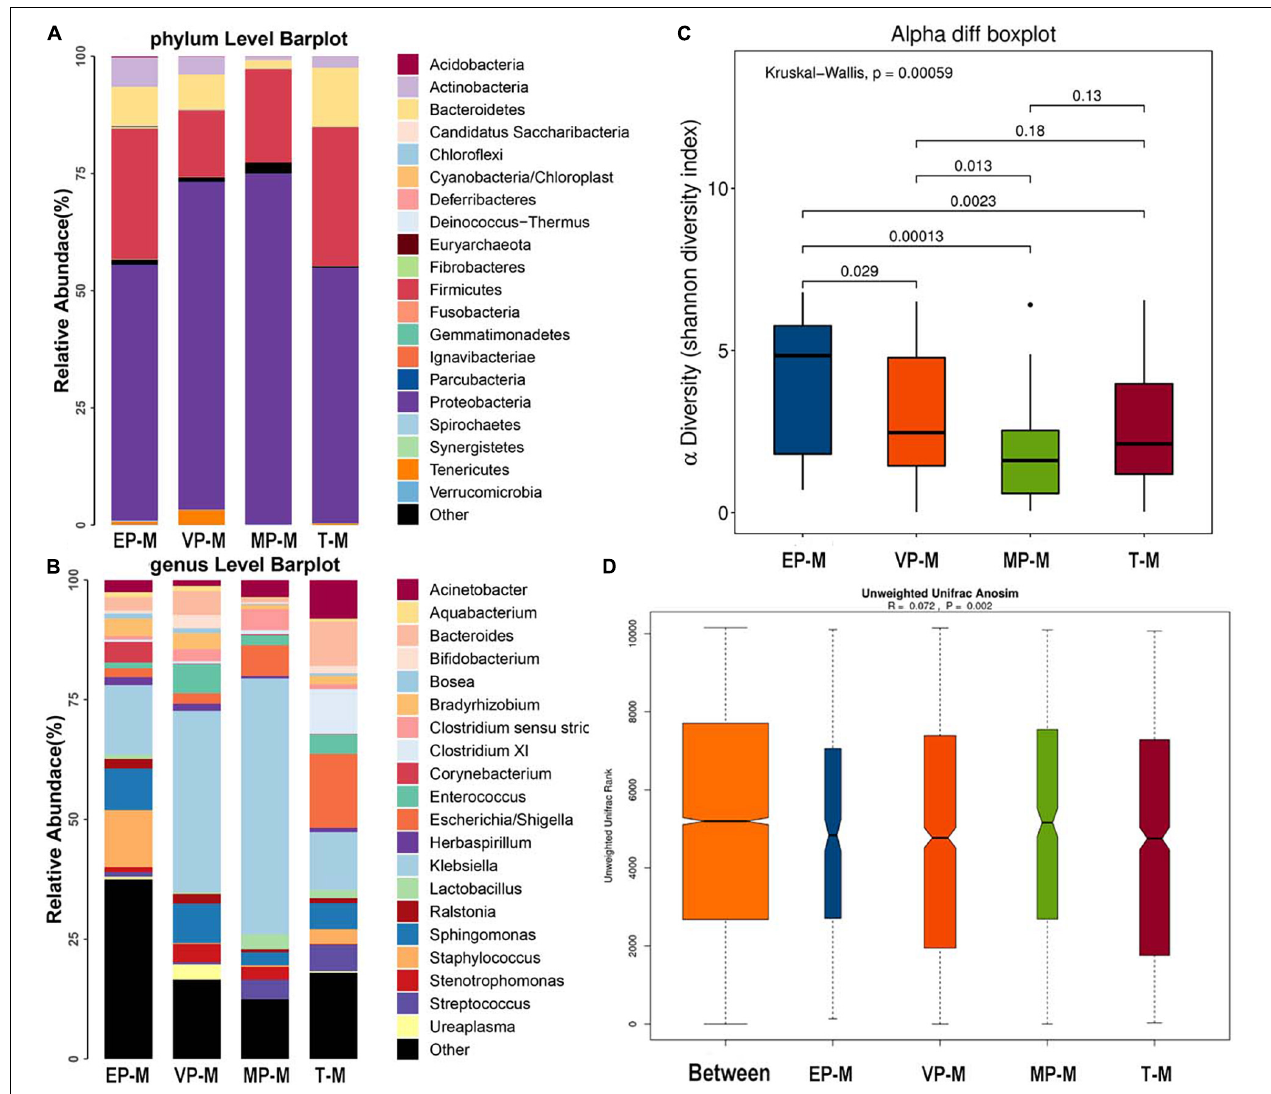
FIGURE 2 | The composition of gut microbiota from neonates with different gestational ages at first day after birth. EP, extremely preterm ( < 28 weeks); VP, very preterm (28–32 weeks); MP, moderate to late preterm (32–37 weeks); T, full-term (37–42 weeks). (A) Comparison of abundance at phylum level. The abscissa is the group name, and the ordinate is the relative abundance of species. Different colors correspond to different species names, and the length of the color block indicates the relative abundance of the species represented by the color block. (B) Comparison of abundance at genus level. The abscissa is the group name, and the ordinate is the relative abundance of species. Different colors correspond to different species names, and the length of the color block indicates the relative abundance of the species represented by the color block. (C) Shannon diversity index of α diversity. The abscissa represents the groups, and the ordinate represents the Alpha diversity index value. (D) Anosim analysis of β diversity. The abscissa represents all samples (Between) and each group, and the ordinate represents the rank of the unifrac distance. When the rank of the Between group is high relative to each of the other groups, it indicates that the between-group difference is greater than the within-group difference. R is between ( − 1, 1), R > 0, indicating that the difference between groups is greater than the difference within the group; R < 0, indicating that the difference within the group is greater than the difference between the groups, the reliability of statistical analysis is represented by P , P < 0.05 indicates statistical